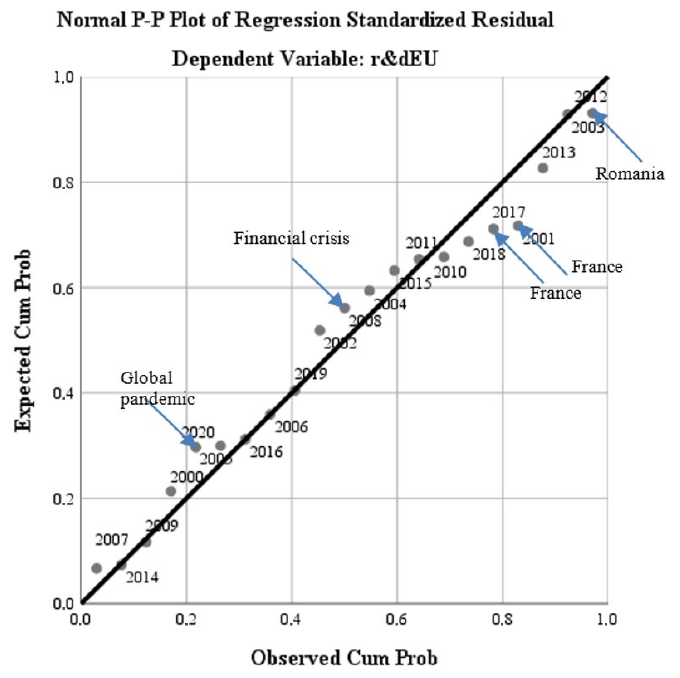
Figure 12. Variations/inflections of the normal distribution from the predicted line during 2000–2020. Source: Data operated under IBM-SPSS 25 (IBM, Armonk, NY, USA). Table 11. Connecting research hypotheses with policy This evolution demonstrates the H4 hypothesis.